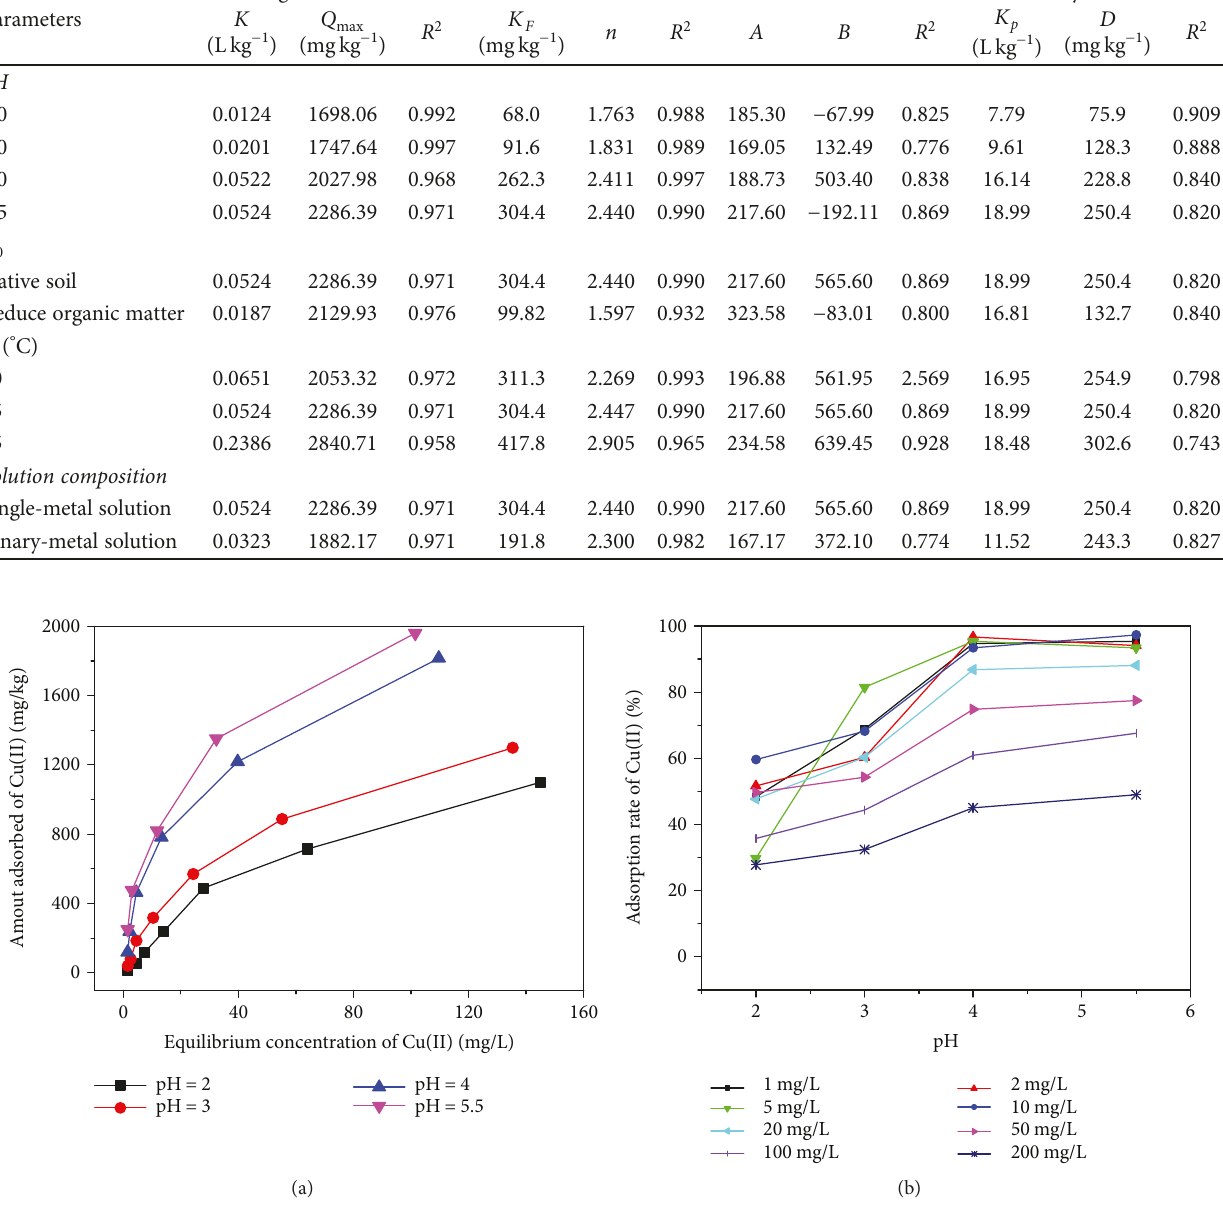
Table 4: Adsorption isotherm model parameters and coe ffi cient of determination ( R 2 ) for adsorption of Cu(II) at di ff erent conditions.